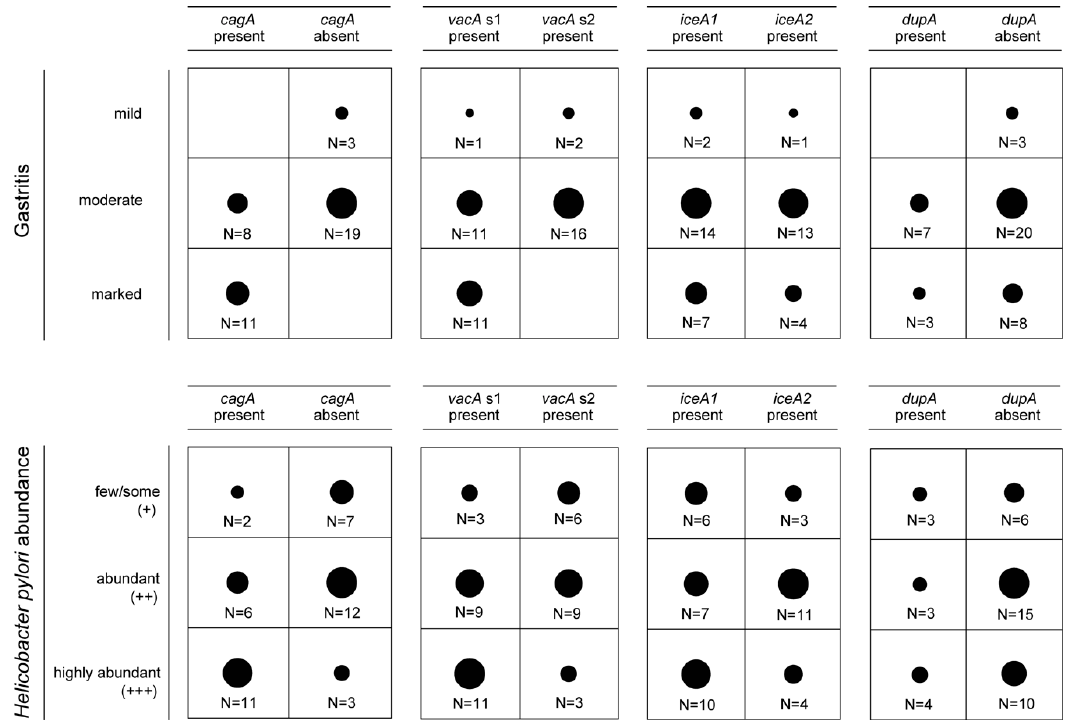
Figure 3. Assessment of the association between the presence of cagA , vacA , iceA and dupA and the severity of gastritis and H. pylori abundance in gastric biopsy specimens.